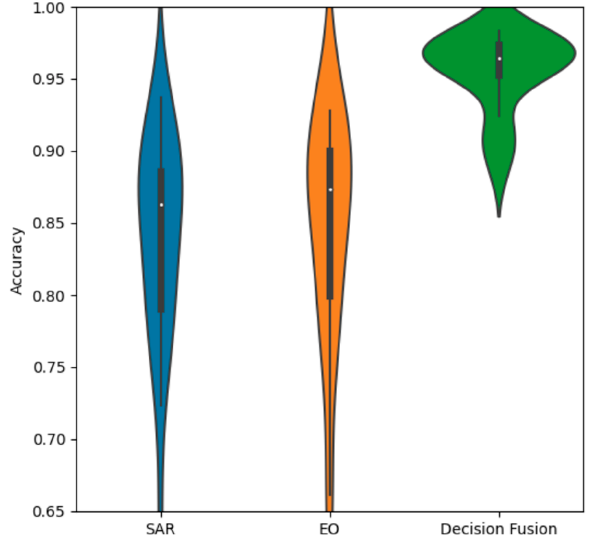
Figure 15. Accuracy distributions of decision fusion vs. SAR and EO.